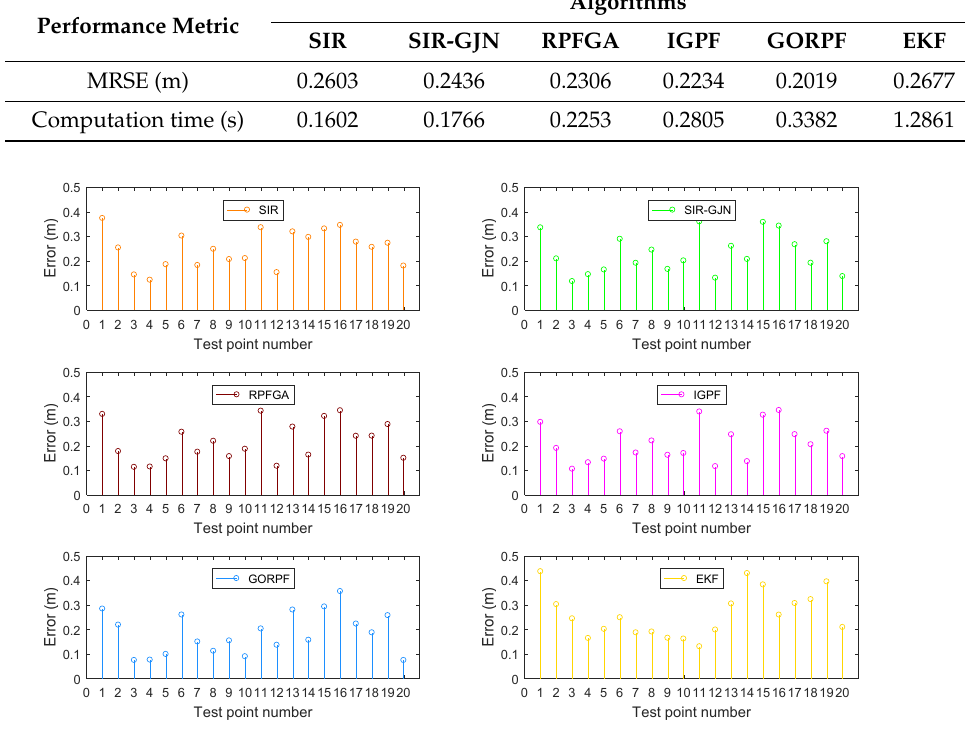
Figure 7. The positioning errors at the twenty test points of the six algorithms.